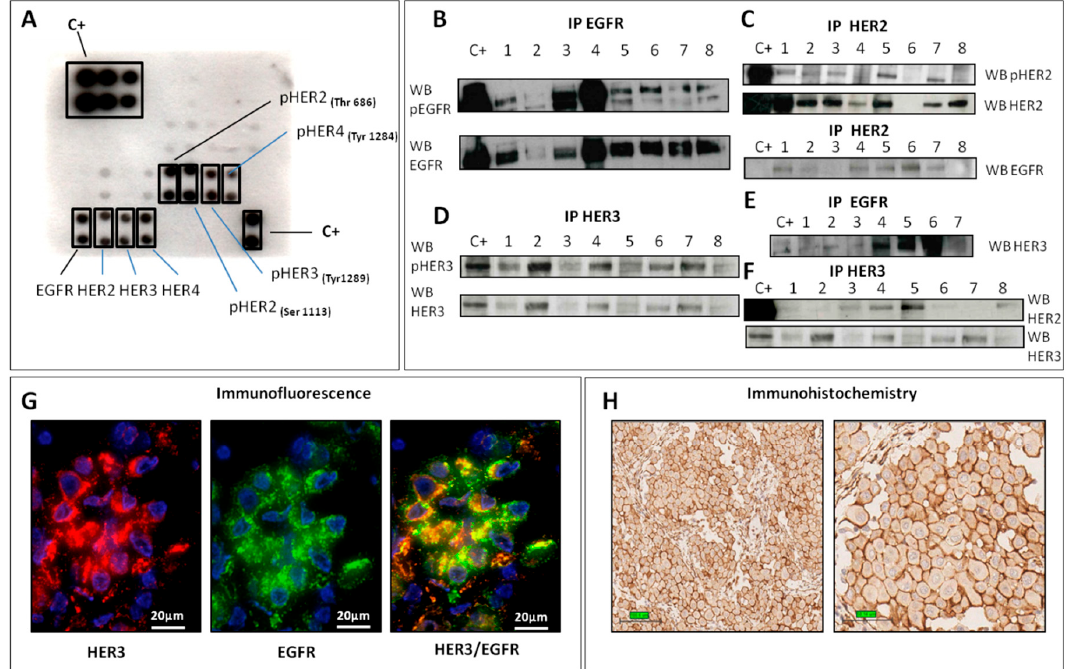
Figure 1. HER family analysis. ( A ) EGFR phosphorylation antibody array revealed phosphorylation of HER2 (T686 and S1113), HER3 (T1289), and HER4 (T1284), as well expression of EGFR, HER2, HER3, and HER4. One milligram of total protein lysate was used for IP experiments, and 20 µl of immunoprecipitated protein was used for WB. A431 (EGFR/HER3) and SKBr3 (HER2) cell lysates were used as positive control for p- and total protein. ( B ) EGFR IP / WB experiments confirmed phosphorylation (upper box) and expression (bottom box) of EGFR. ( C ) HER2 IP / WB experiments confirmed phosphorylation (upper box) and expression (middle box) of HER2; HER2 / EGFR co-IP experiments revealed HER2-EGFR heterodimerization (bottom box). ( D ) HER3 IP / WB experiments confirmed phosphorylation (upper box) and expression (bottom box) of HER3. ( E ) EGFR / HER3 co-IP experiments revealed HER3-EGFR heterodimerization. ( F ) HER3 / HER2 co-IP experiments revealed HER3-HER2 heterodimerization; HER3 WB revealed HER3 expression. ( G ) HER3 (red) and EGFR (green) IF provided evidence of HER3 and EGFR co-expression (yellow). ( H ) IHC showed HER3